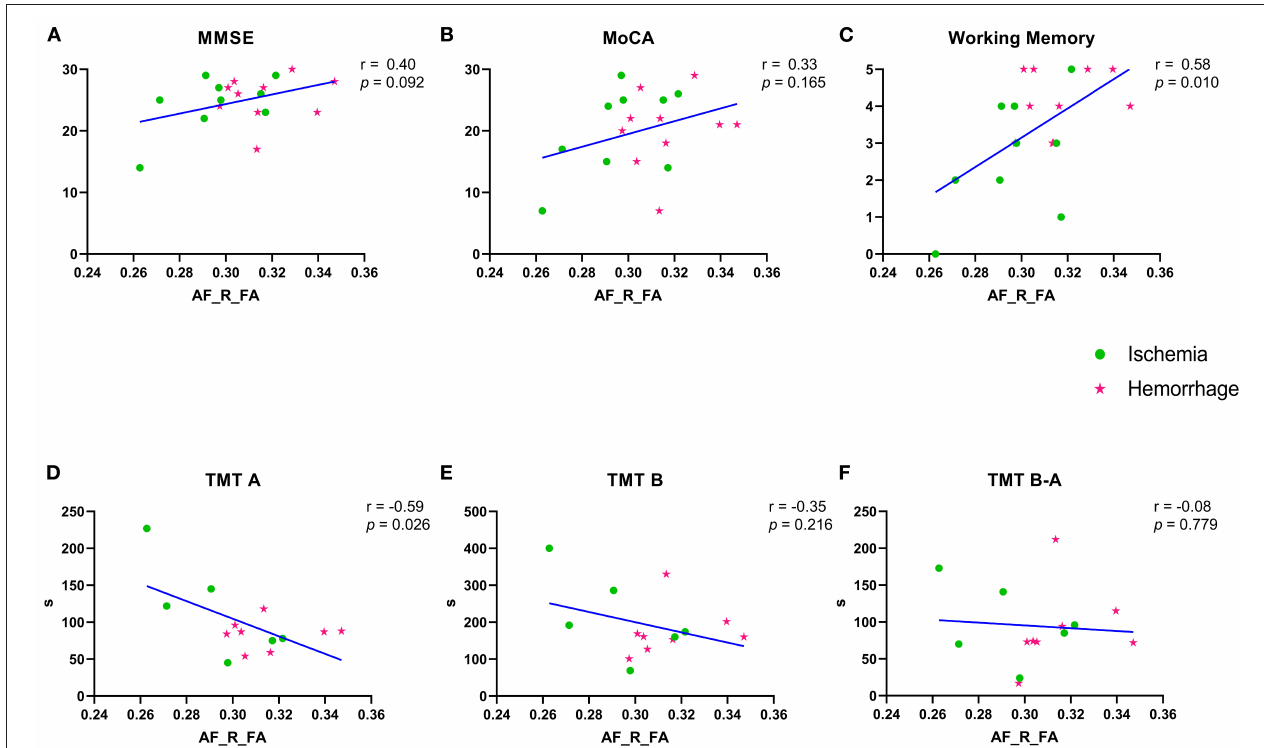
FIGURE 5 | (A–F) Correlation between the FA values of right AF and variable cognitive performances. Green spots represent the ischemia group and red stars represent the hemorrhage group. MMSE, Mini–Mental State Examination; MoCA, Montreal Cognitive Assessment; TMT-A/-B, Trail Making Test parts A and B; FA, fractional anisotropy; AF, arcuate fasciculus. R means right. TMT B-A means the subtraction of two